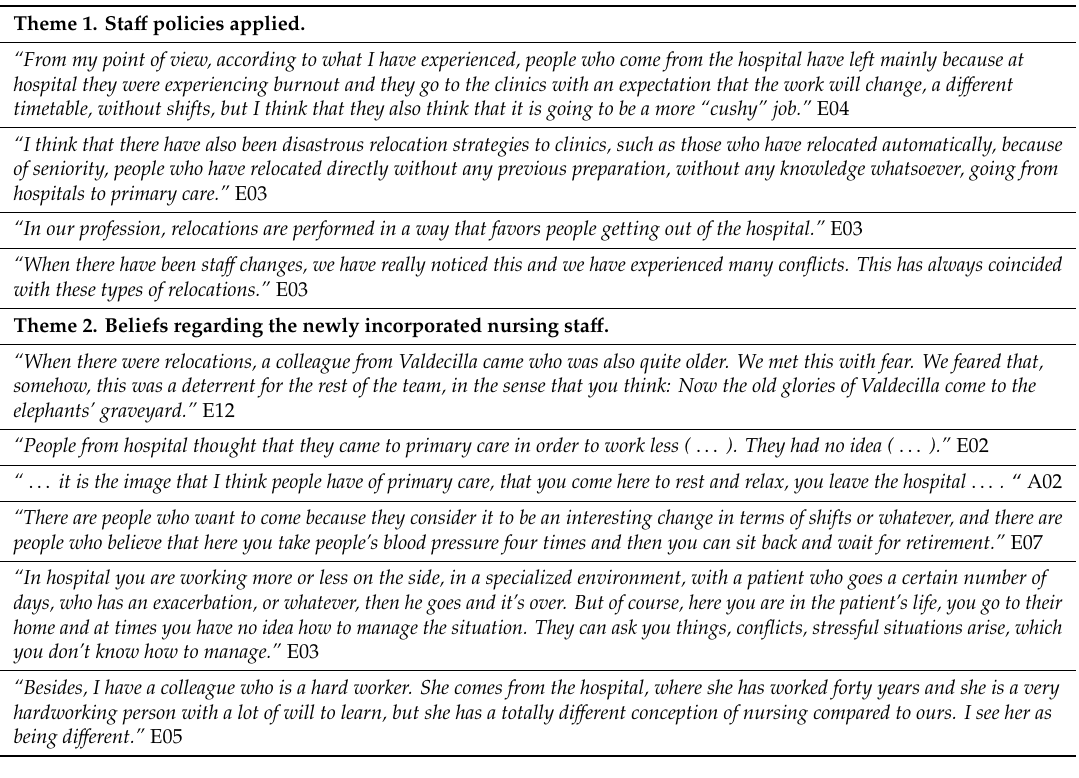
Table 5. Literal excerpts from the